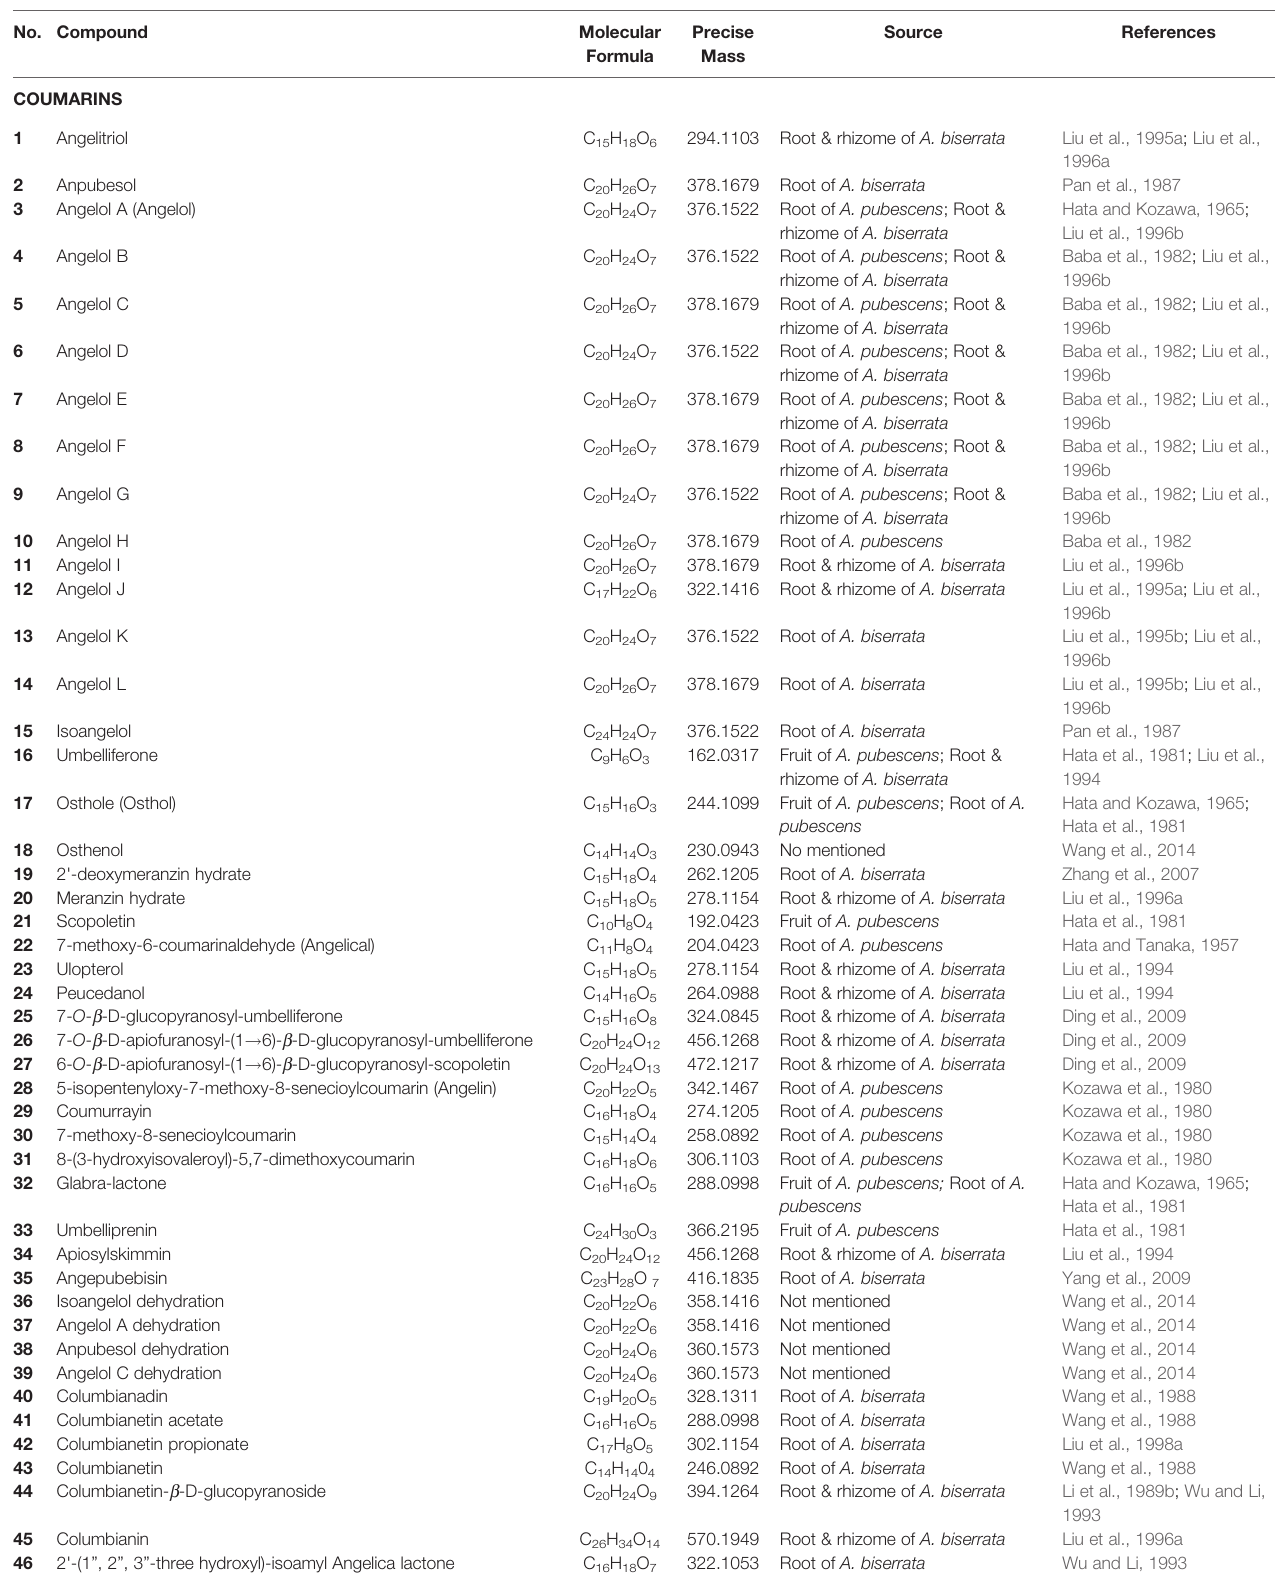
TABLE 3 | Chemical constituents isolated from medicinal plants as